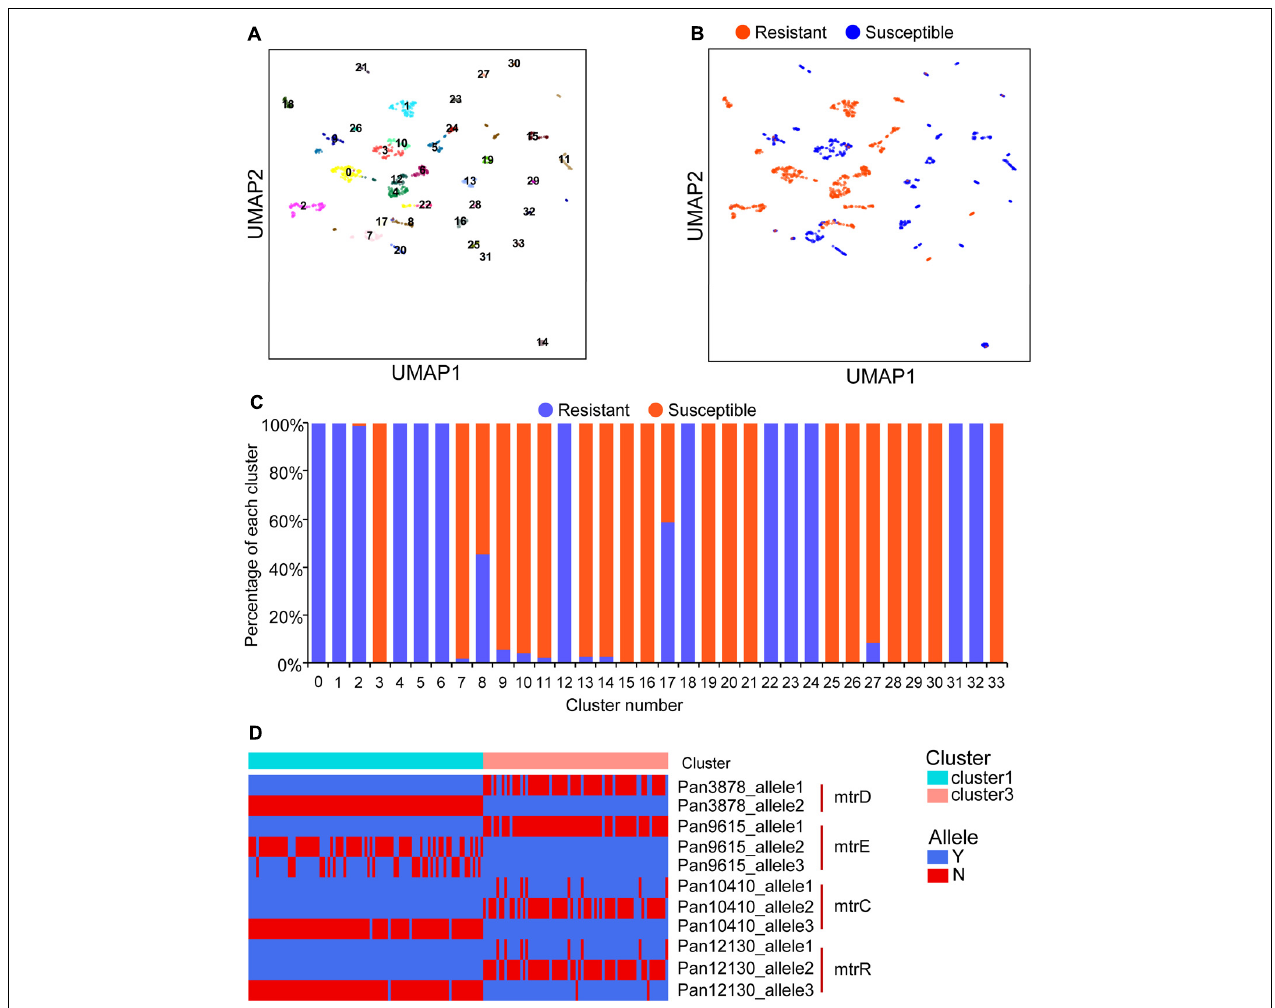
FIGURE 3 | PARMAP (Prediction of Antimicrobial Resistance by MAPping genetic alterations in pan-genome) analysis reveals genetic heterogeneity in antimicrobial resistance (AMR), genes of Neisseria gonorrhoeae . (A) Clustering analysis of strains with and without ciprofloxacin resistance based on gene allele features using the uniform manifold approximation and projection (UMAP), algorithm; each number represents a distinct cluster. (B) Resistant phenotypes of the distinct clusters; orange indicates ciprofloxacin resistance, and blue indicates ciprofloxacin susceptibility. (C) Percentages of resistant strains in different clusters. (D) Comparison of gene alleles between clusters 1 and 3 showed that they have distinct mutation profiles regarding the mtrD, mtrE, mtrC, and mtrR genes, indicating that specific genetic alterations confer the AMR phenotype in cluster